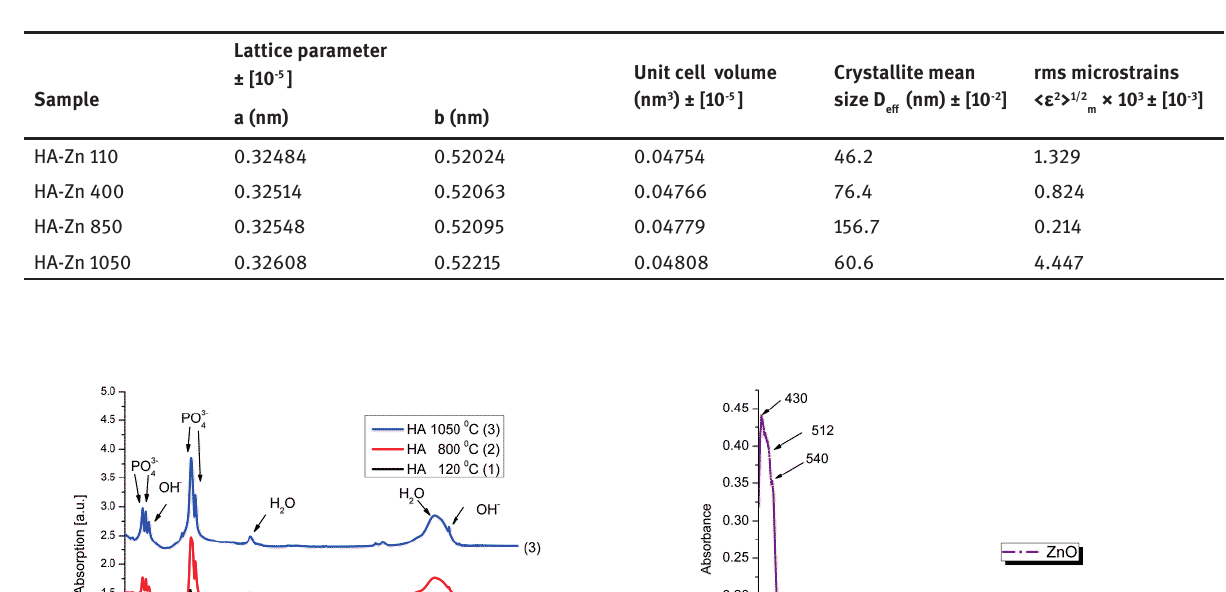
Table 1: Lattice parameters and microstructure parameters of the ZnO hexagonal crystalline phase in HA-ZnO samples